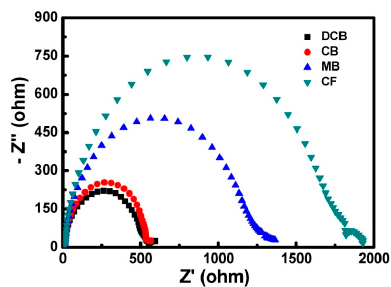
Figure 13. Electrochemical impedance spectroscopy (EIS) Nyquist plots of the PSCs based on various ETL solvents.